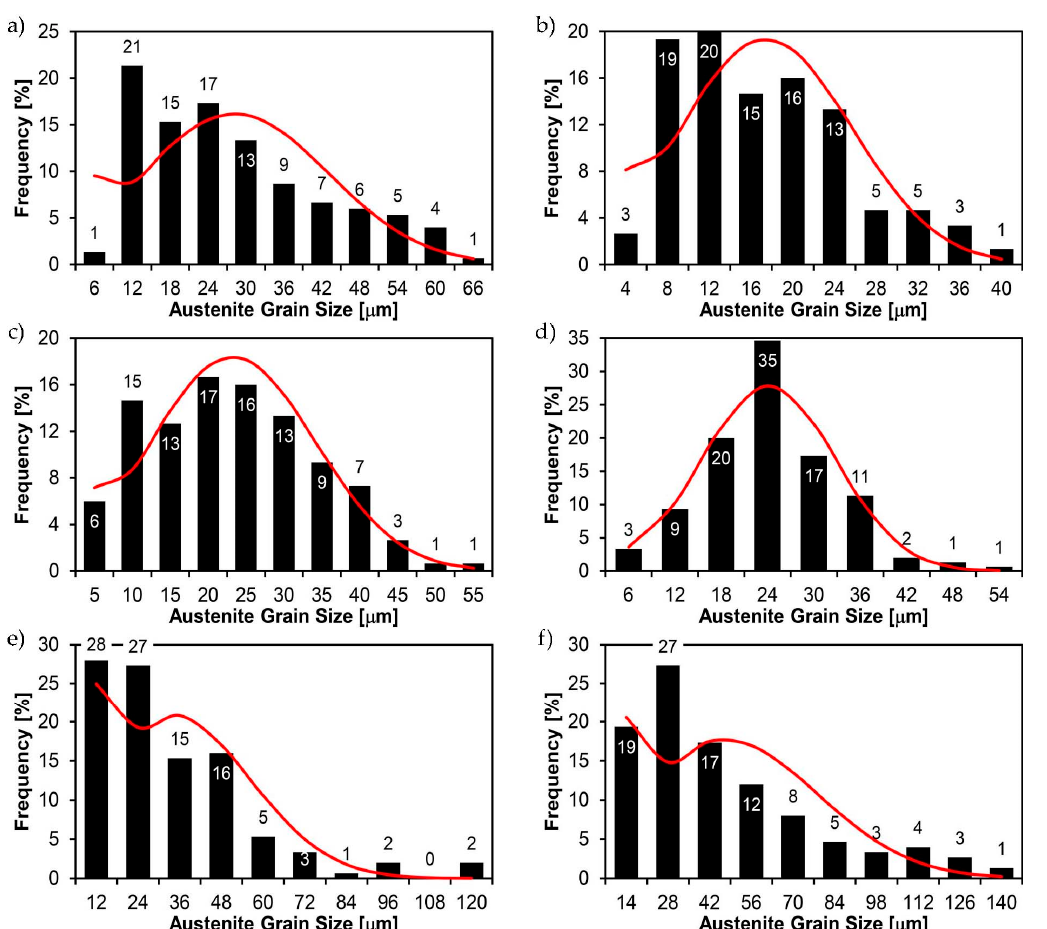
Figure 63. Frequency ranges and normal occurrence distributions of determined austenite grain sizes in the welded joint zone of Hardox 450 steel marked as FGH(AZ) in Figure 2: ( a ) normalised state; ( b ) delivery state (directly after welding); ( c ) after austenitising at 900 ◦ C for 60 min; ( d ) after austenitising at 1000 ◦ C for 60 min; ( e ) after austenitising at 1100 ◦ C for 120 min; ( f ) after austenitising at 1200 ◦ C for 120